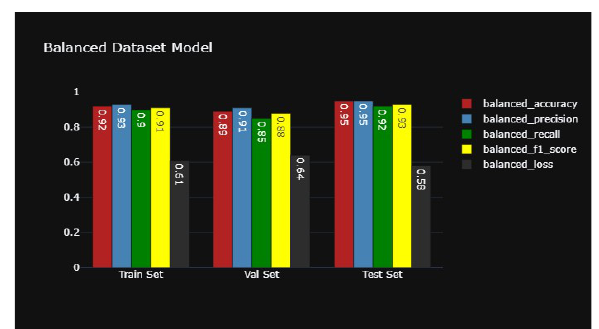
Fig. 7. Balanced dataset model performance metrics